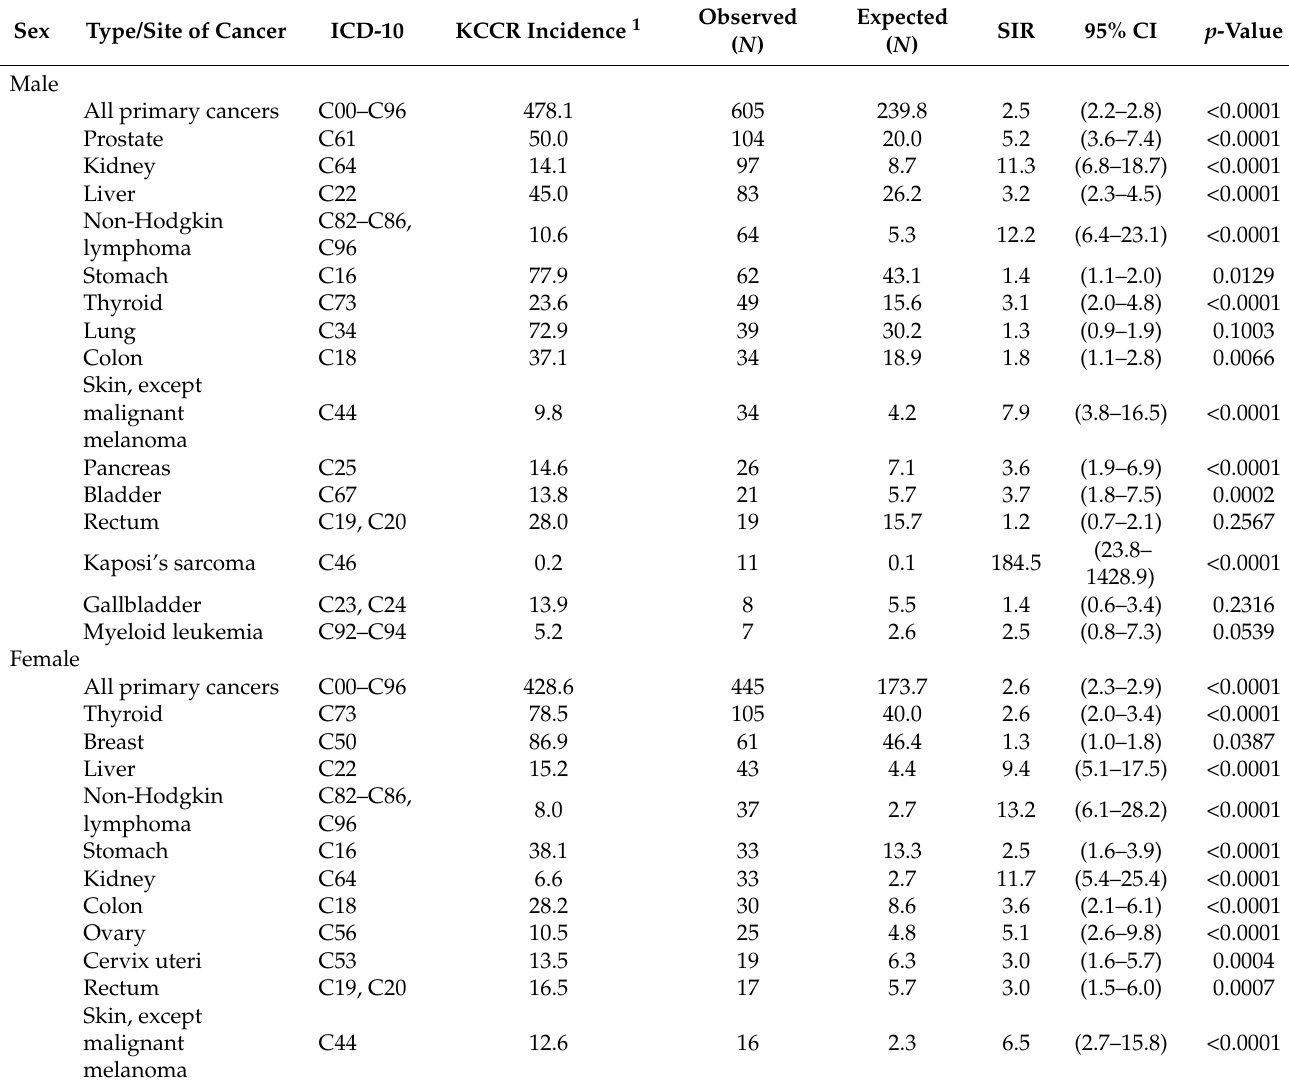
Table 2. Age-adjusted standardized incidence ratio by de novo primary cancer types after kidney transplantation during 16